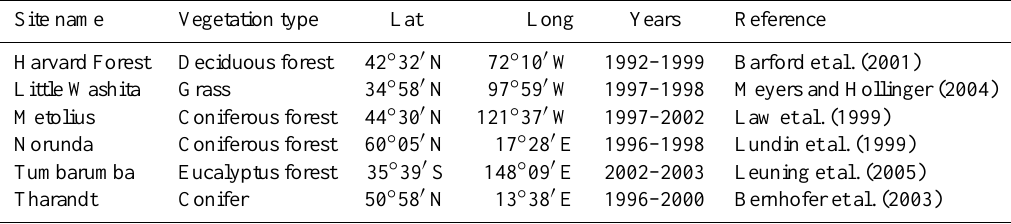
Table 1. The six flux tower sites, vegetation type, location, period of record and reference to the data sets.